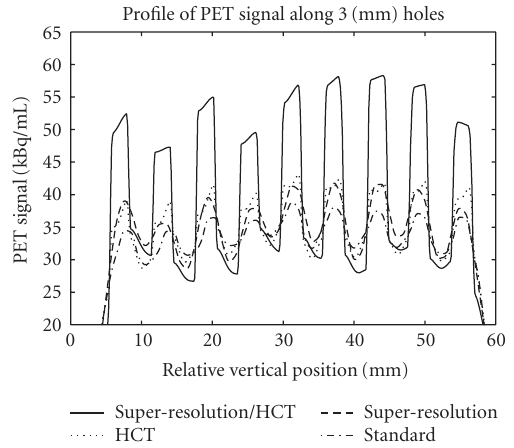
Figure 7: A plot of pixel values through the 3mm features of the phantom images in Figure 6. The super-resolution (dashed line) and HCT (dotted) profiles give better contrast than the standard method (dashed and dotted). The combination of HCT and super- resolution gives the best contrast (solid black).